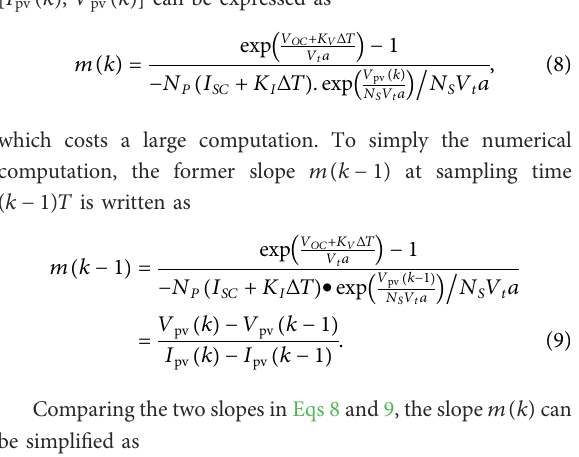
without a modulator. The overall control topology is shown in Figure 5. The reference I pv* ( k + 1 ) is obtained by the uni fi ed voltage regulation and MPPT control, which is detailed in the next section. With the proposed modi fi ed MPC, the PV sources can track the reference accurately.